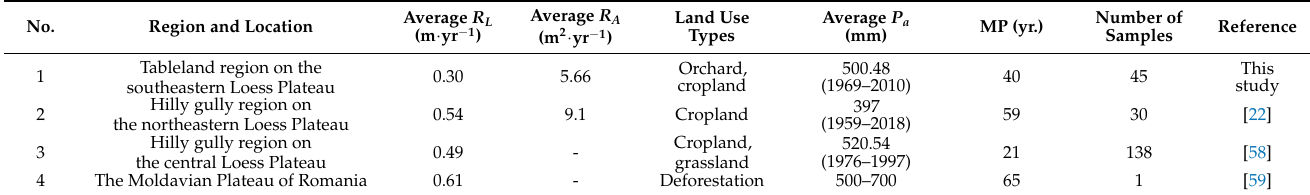
Table 6. Gully growth rates in different parts of the Loess Plateau in published papers and this study.